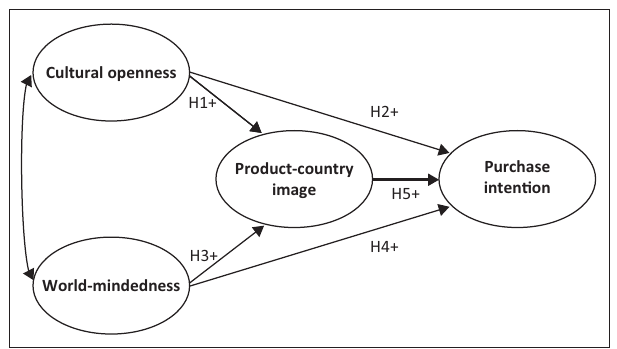
FIG URE 1: Study model and